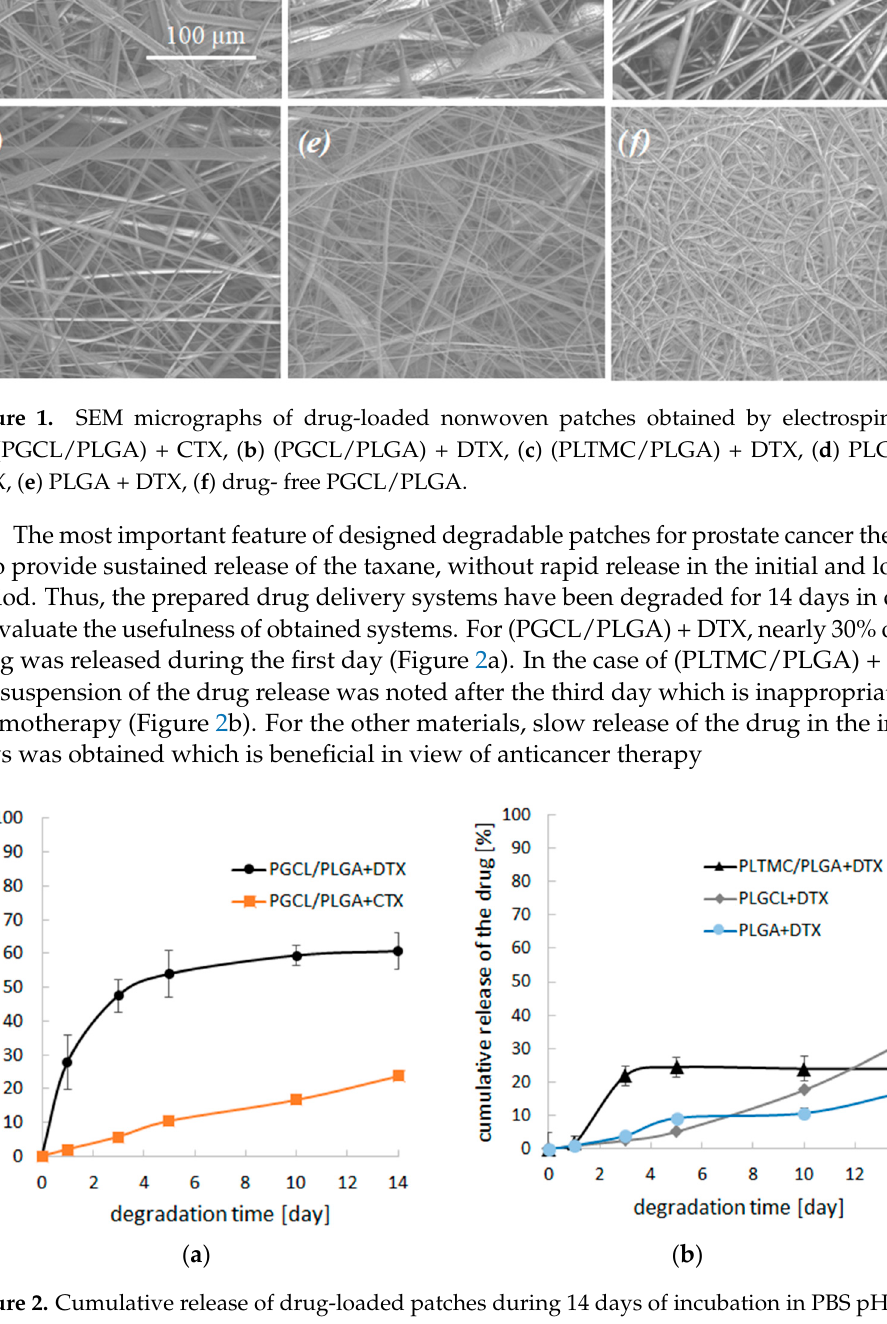
Figure 3. SEM micrographs of drug-loaded nonwoven patches; ( a ) PGCL/PLGA + CTX, ( b ) (PGCL/PLGA) + DTX, ( c ) (PLTMC/PLGA) + DTX, ( d ) PLGCL + DTX, ( e ) PLGA + DTX, ( f ) drug- free PGCL/PLGA after fast degradation scan (14 days of incubation in PBS pH = 7.4 and 37 °C). On the basis of a 14-day degradation scan and drug release (PGCL/PLGA) + CTX and PLGCL + DTX patches were selected for further long-term verification. 3.2. Taxane Delivery Systems: Long-Term Drug Release Study and Degradation Profile